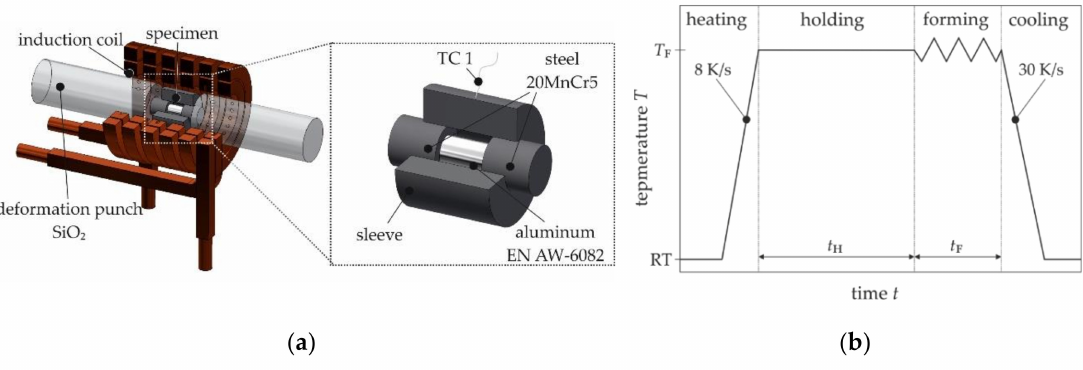
( a ) Schematic test setup of the analogy experiments on a forming dilatometer, ( b ) temperature–time curve used in the experiments.